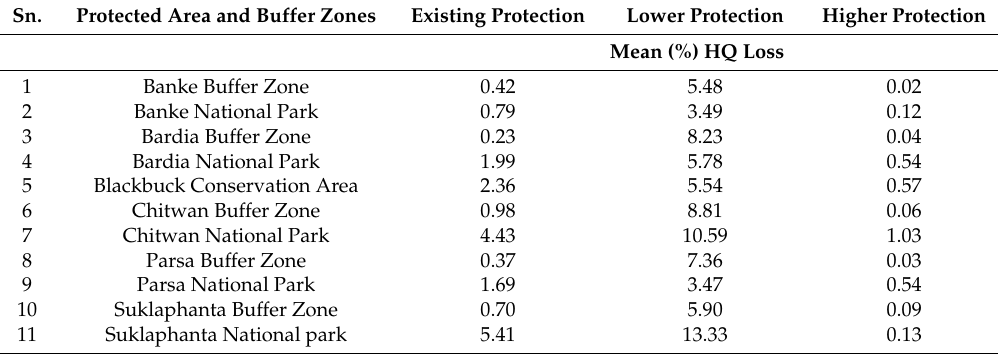
Figure 4. Spatial distribution of current habitat quality in Terai Arc Landscape. Table 3. Mean percent habitat quality loss in the protected areas and buffer zones.